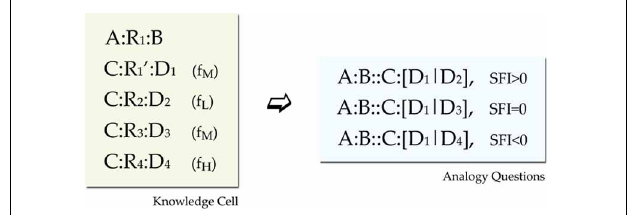
FIGURE 4 | Training environment design. Minimal design for a knowledge cell. The source proposition provides the A:B part of the analogy question, the C:D1 provides the correct response and there are three foils with various associations (shown in parentheses as Low, Medium, and High training frequency). Further details of the environment design are presented in the Appendix.